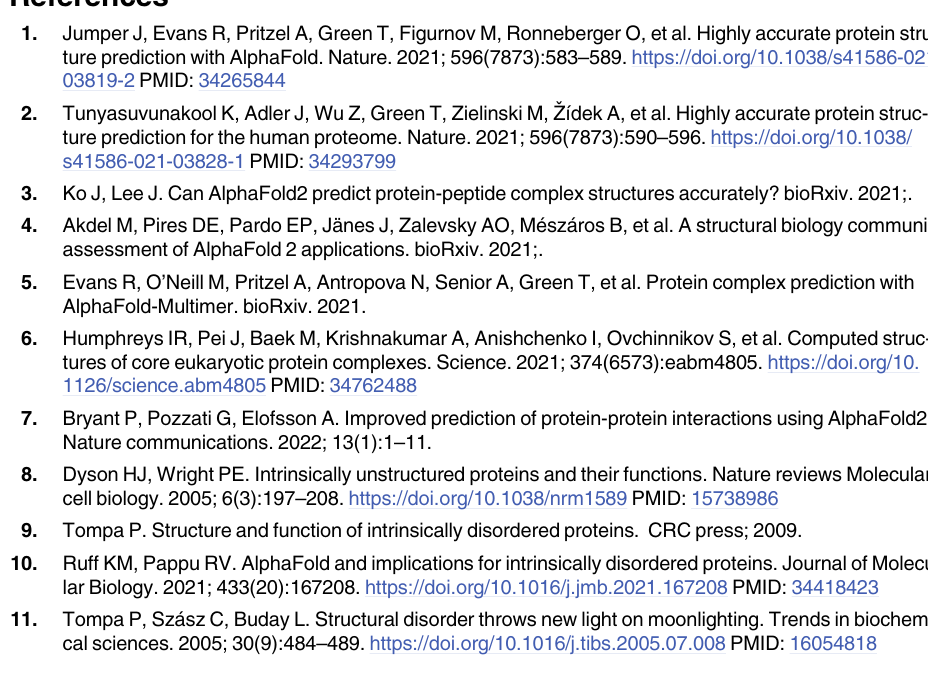
S3 Fig. We show the PPV vs. 1-NPV for all k - shell tests (with k � 2) predictions in our database. Each point corresponds to a prediction for a parent node. The colour encodes the local density of this region. As in Fig 2A, the 75% of the predictions lie above the random guess